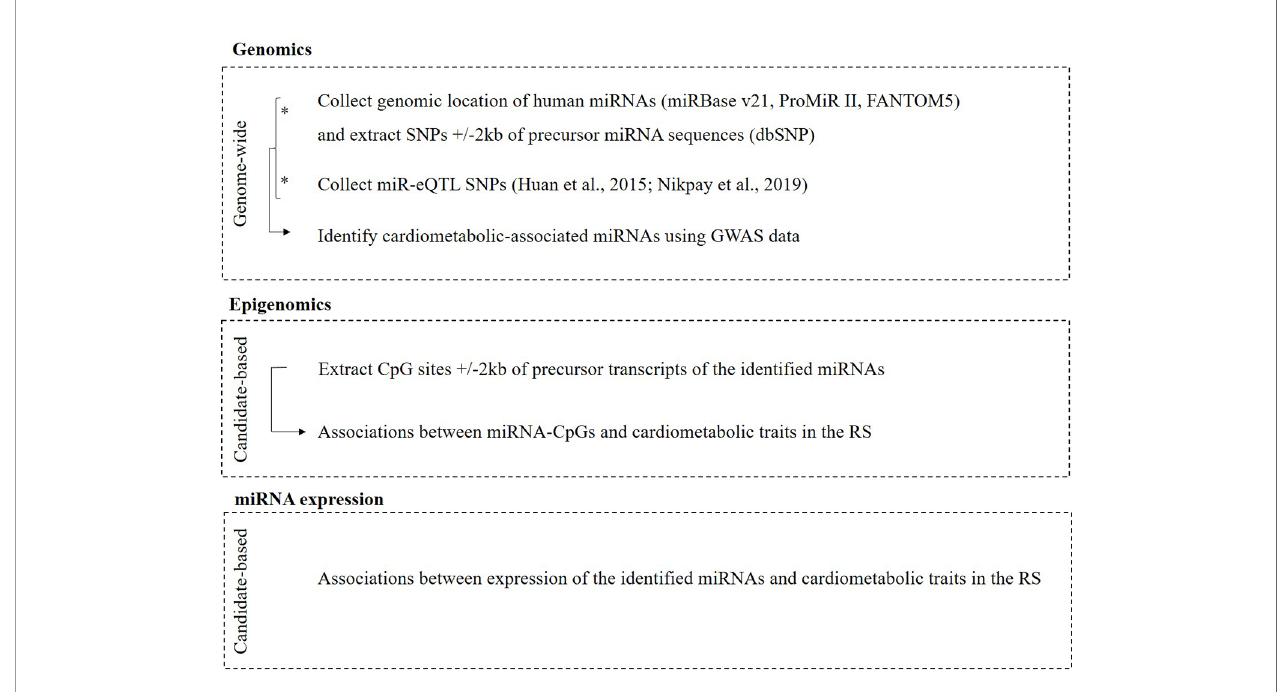
FIGURE 1 | Overview of the multi-omics layers used in this